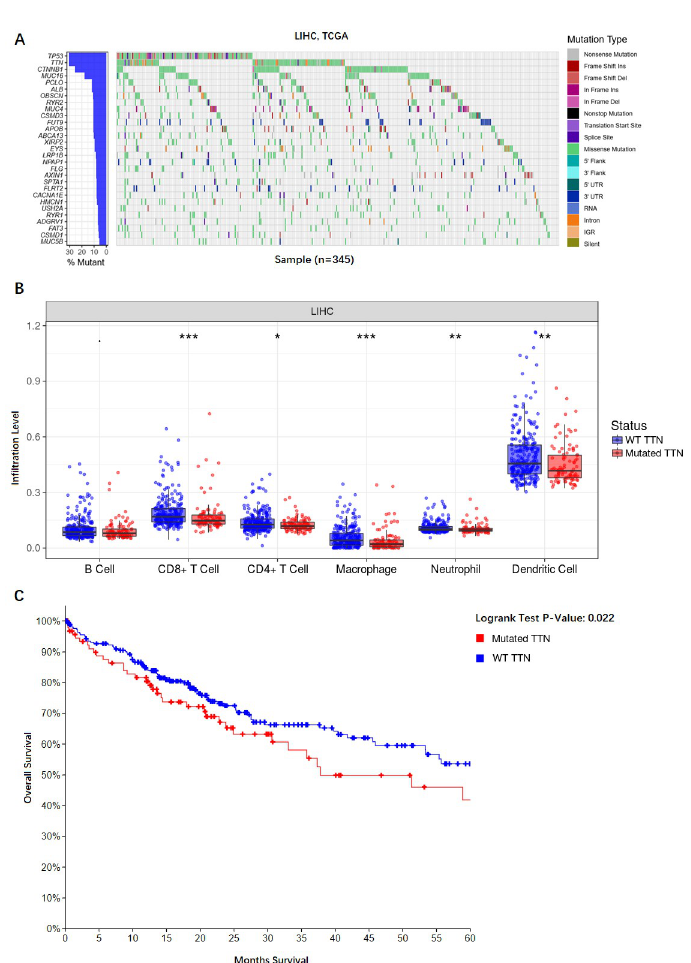
(CD8 + T cells, Macrophage, Neutrophil, and Dendritic Cells) show significantly higher enrichment levels in TTN- wildtype than in TTN- mutated cancers in LIHC, (C) Kaplan-Meyer survival curves showed that TTN mutation have a negative correlation with OS in